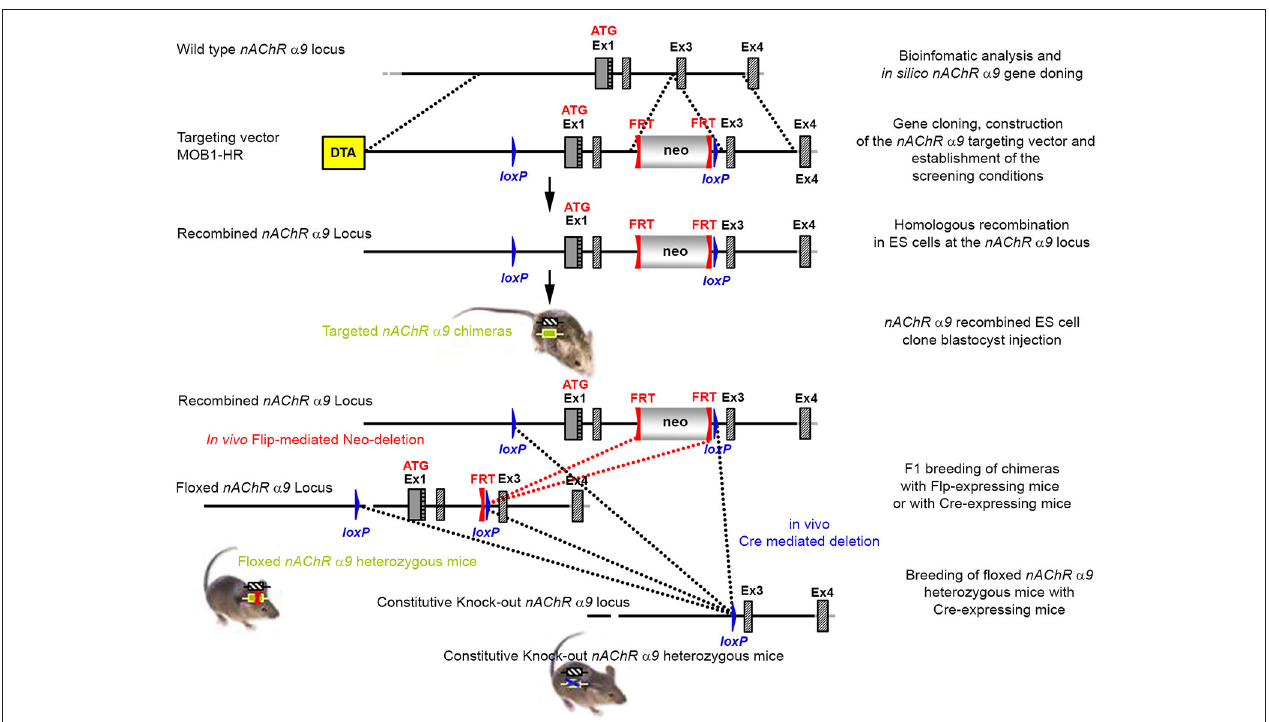
FIGURE 1 | The targeting strategy for the generation of the CHRNA9 knockout. Boxes represent exons. Solid line represents intronic sequences. LoxP and FRT elements are shown as blue and red triangles, respectively. Neo and DTA boxes represent the neomycin positive selection cassette and the Diphtheria Toxin A negative selection cassette. The constitutive KO was generated by breeding the floxed nAChR α 9 heterozygous mice with Cre-expressing